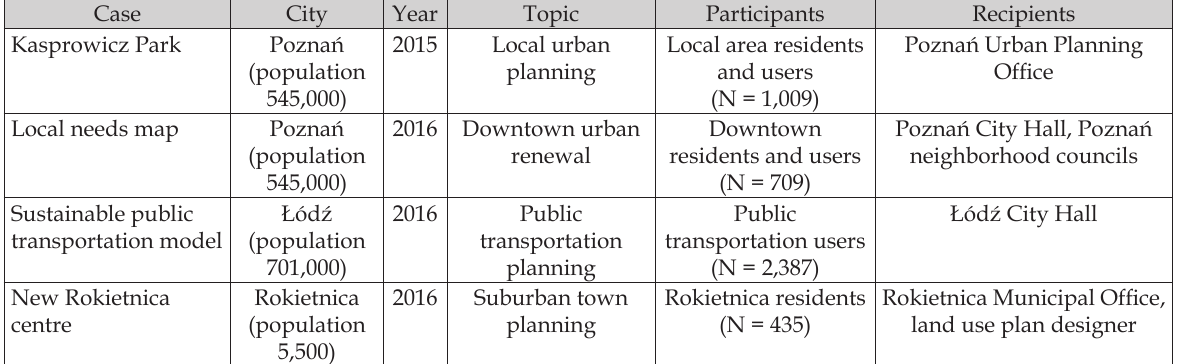
Table 1. Description of selected geo-questionnaire cases in